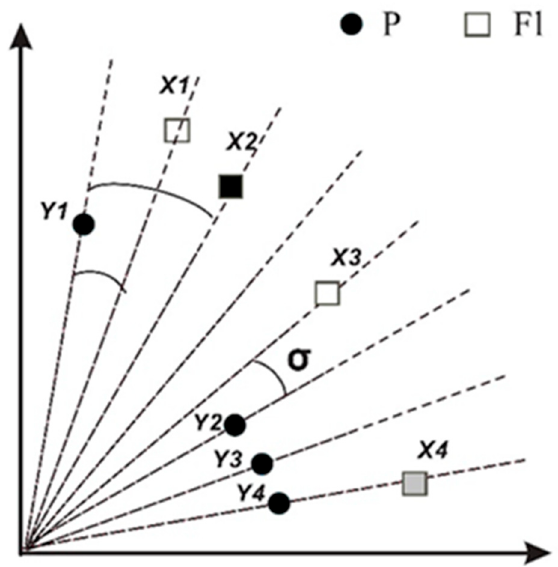
Figure 2. Vector Angle Selection Strategy.